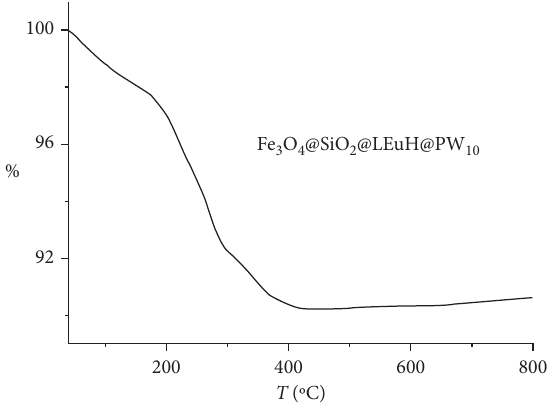
Figure 13: Thermogravimetric analysis curves for Fe